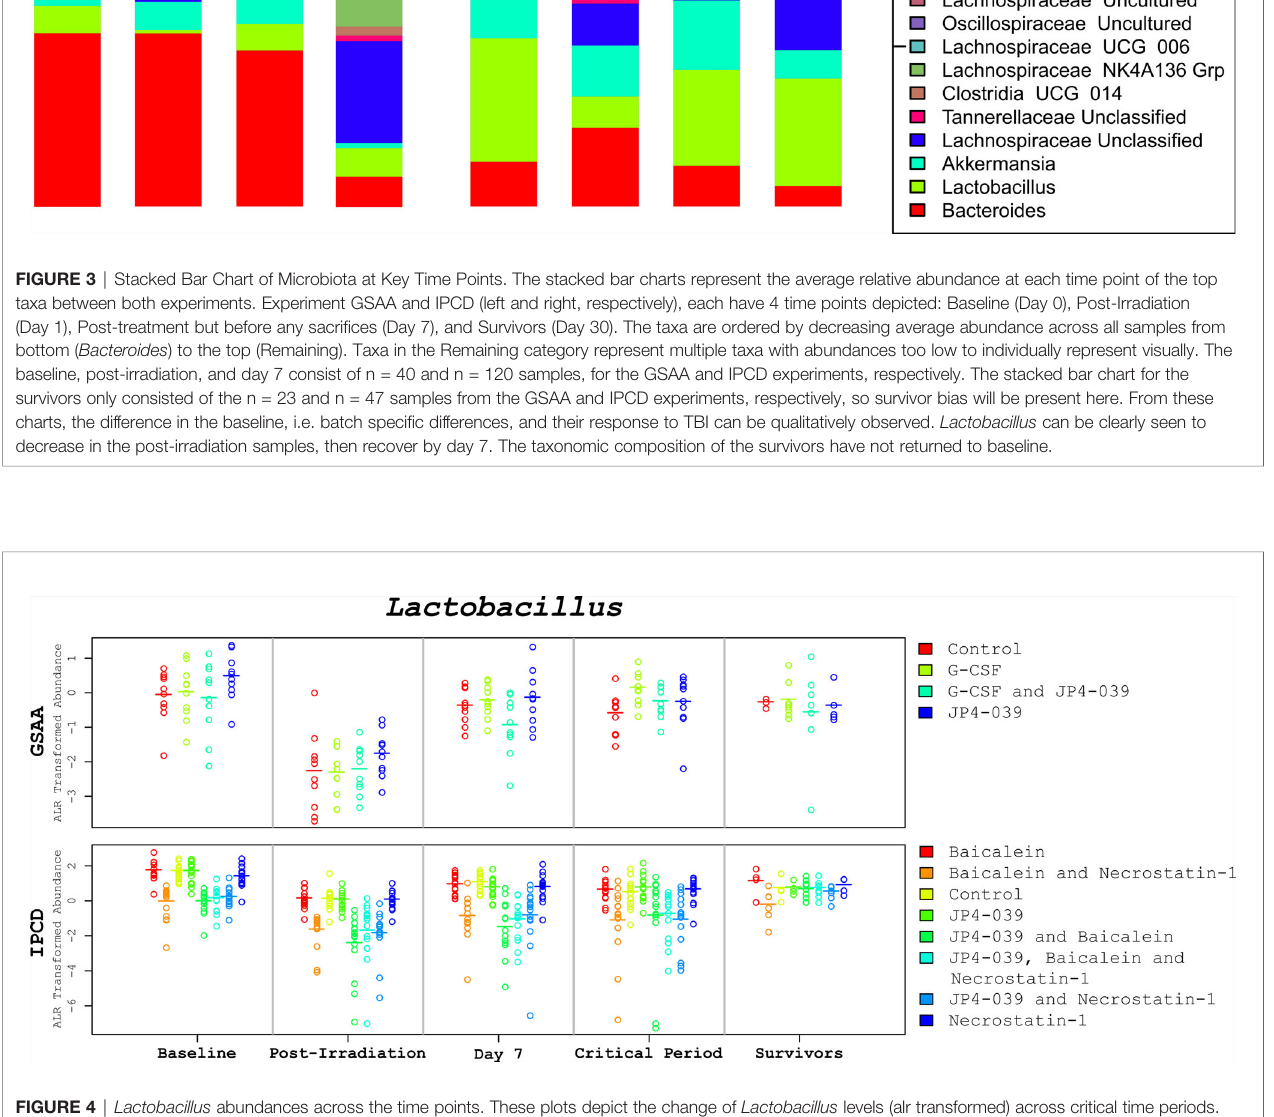
FIGURE 4 | Lactobacillus abundances across the time points. These plots depict the change of Lactobacillus levels (alr transformed) across critical time periods. The GSAA and IPCD experimental results are positioned at the top and bottom, respectively. Each annular glyph represents an individual mouse and each horizontal bar represents the median for each treatment group. The order of the treatment groups from left to right, match the colors and order in the legend on the right margin, from top to bottom. The values represented in the critical period (days 9-24) are the average across the available samples for each mouse. These plots illustrate not only how the median Lactobacillus levels change between time points, but also the degree of variation within each treatment group. In spite of treatment group speci fi c variation at baseline, the relative change of Lactobacillus appears to be conserved, suggesting that the observed changes are not simply an artifact of mean